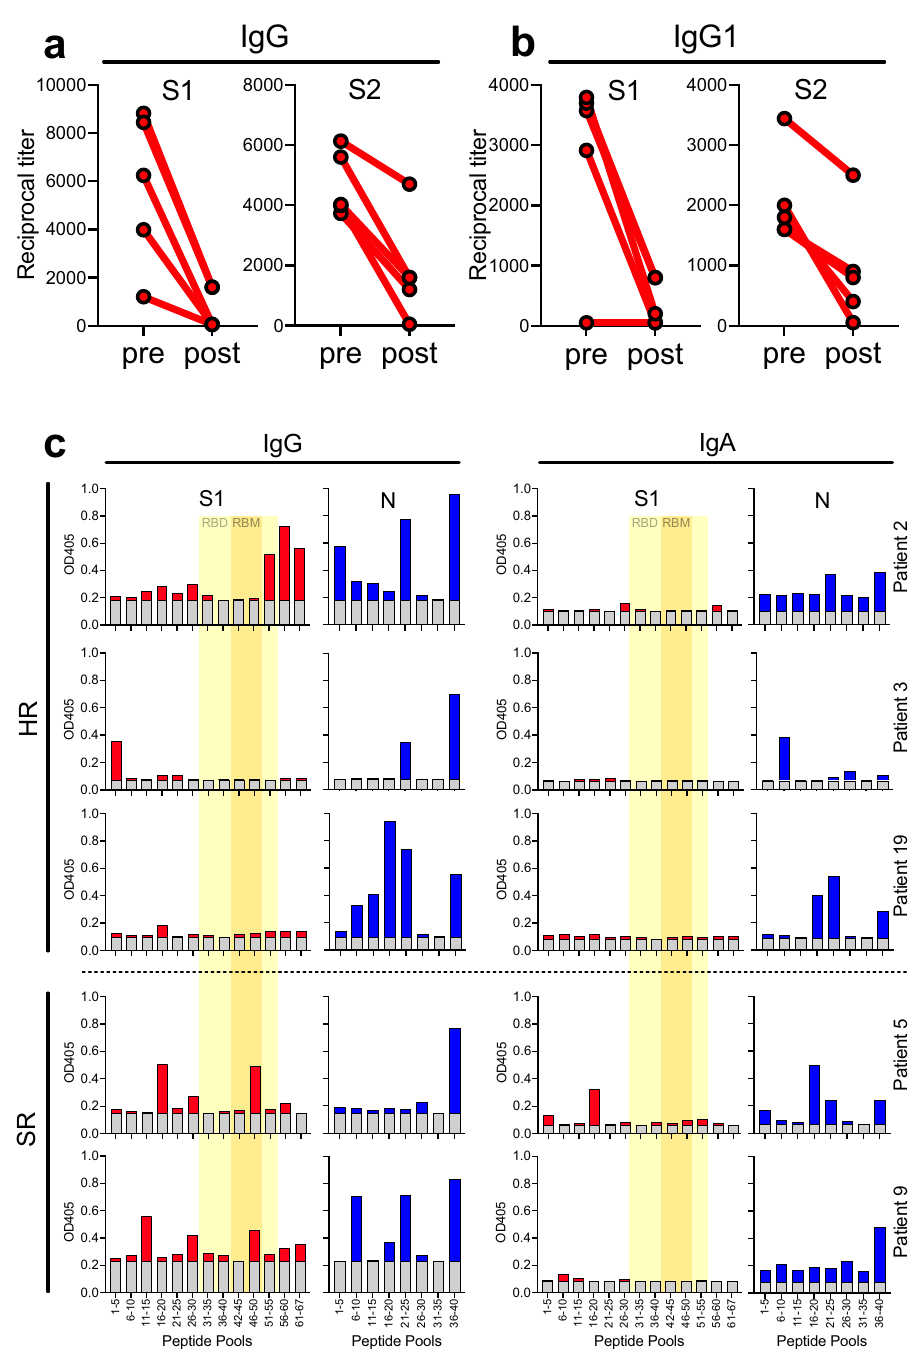
Fig. 6 Relevance of glycosylated and linear SARS-CoV epitopes. Plasma samples from fi ve patients with known anti-SARS-CoV reactivity were analyzed for a IgG and b IgG1 titers against deglycosylated vs. native S1 and S2 proteins. c We used peptide pools of fi ve 20mer peptides each overlapping by 10aa to determine IgG and IgA reactivity against distinct regions within the S1 (red bars) and N (blue bars) proteins. Gray bars indicate background levels. RBD and RBM regions within the S1 protein are highlighted in yellow and orange, respectively. Asterisks indicate statistical signi fi cance of differences as determined by paired two-tailed Student ’ s t test. * p < 0.05; ** p <